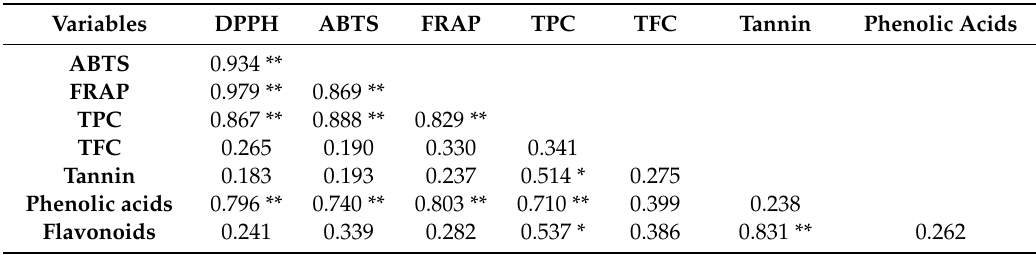
Figure 1. Factor analysis (FA) of the antioxidant assays, phenolic acids and flavonoids determined by HPLC-PDA. Table 5. Pearson’s correlation coefficients (r) for the relationships between antioxidant assays and phenolic contents.